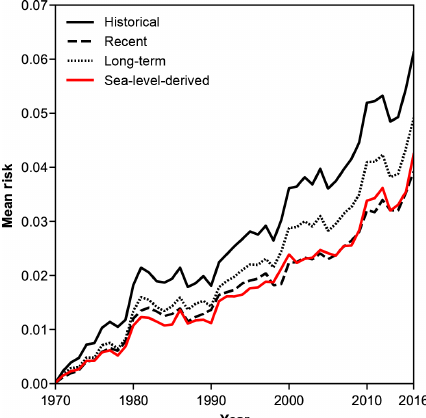
Figure 5. Comparative evolution of mean risk over time under dif- ferent representations of shoreline-change rate (hazard condition): historical (solid black), recent (dashed black), long term (dotted black), and derived from sea level